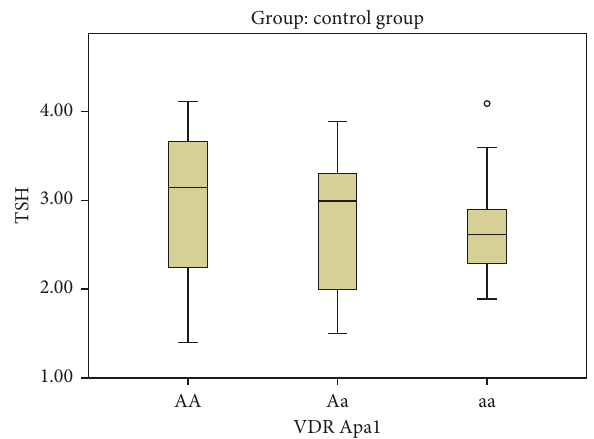
Figure 4: Variation of different Apa1 alleles with TSH level in the control group.